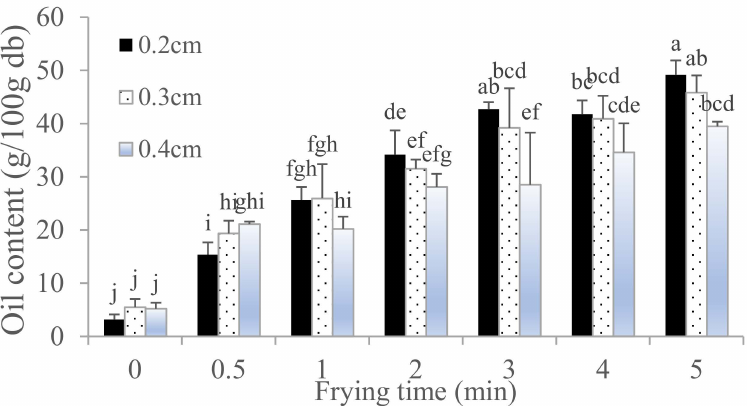
Figure 2. The oil content (dry basis) of fried pork skins were determined every min for 5 min at 105 ◦ C drying using a convection oven. a–j Indicate significant difference between different samples of fried pork skin. ( n = 3; p < 0.05). Table 1. The physical properties of fried pork skin with different raw pork skin thickness under the similar water content. Thickness Frying